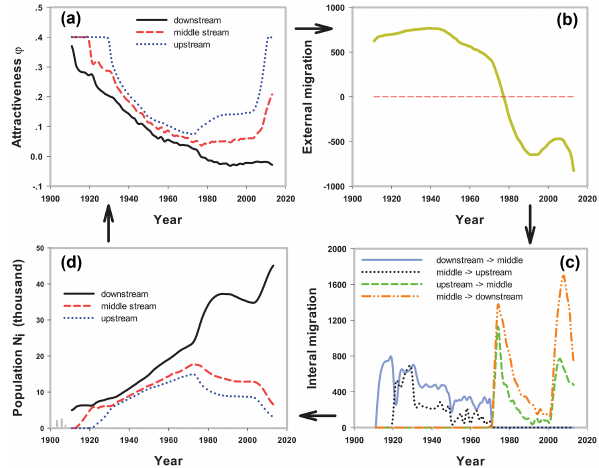
Figure 9. Time variation of population dynamics: (a) attractiveness factor for each of the three settlements; (b) rate of external migra- tion; (c) rates of internal relocation between the three settlements; and (d) size of population in the three